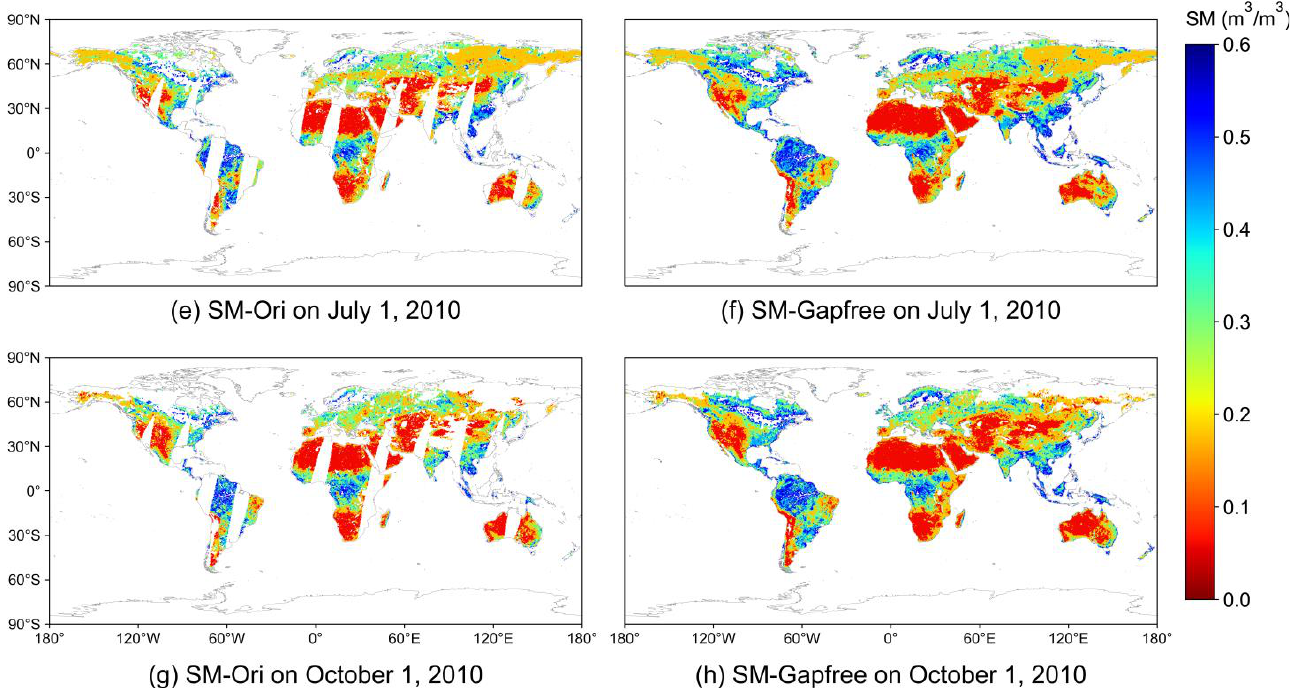
Figure 7. Global daily maps of the original and reconstructed gap-free SM on 1 January, 1 April, 1 July, and 1 October in 2010.